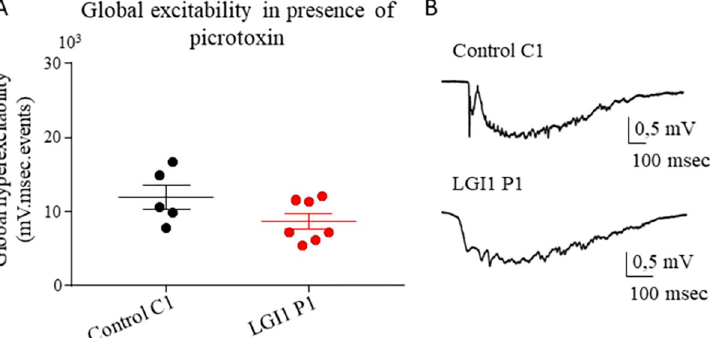
Fig 6. LGI1 abs have no effect on the global hyperexcitability when the inhibitory network was blocked. (A) LFP in presence of 4-AP (40 μ M) and picrotoxin (100 μ M) were recorded in CA1 area of acute hippocampal slices from mice infused for 7 days with control C1 or LGI1 P1 IgG. No difference was found in the global hyperexcitability between control C1 IgG and LGI1 P1 IgG infused neuronal network when recordings were performed in presence of picrotoxine (Mann-Whitney test p = 0.20, n Ctrl = 6 mice, n LGI1 = 7 mice). (B) Examples of ictus recorded in presence of 4-AP and picrotoxine. Data are represented as mean ± SEM (n Ctrl = 6 mice, n LGI1 = 7 mice).